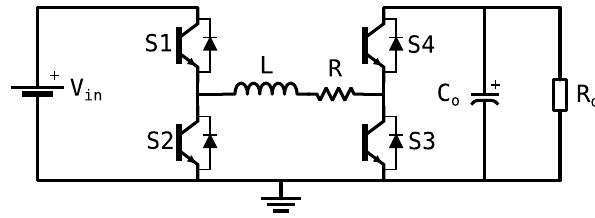
Figure 1. Synchronous Buck–Boost circuit